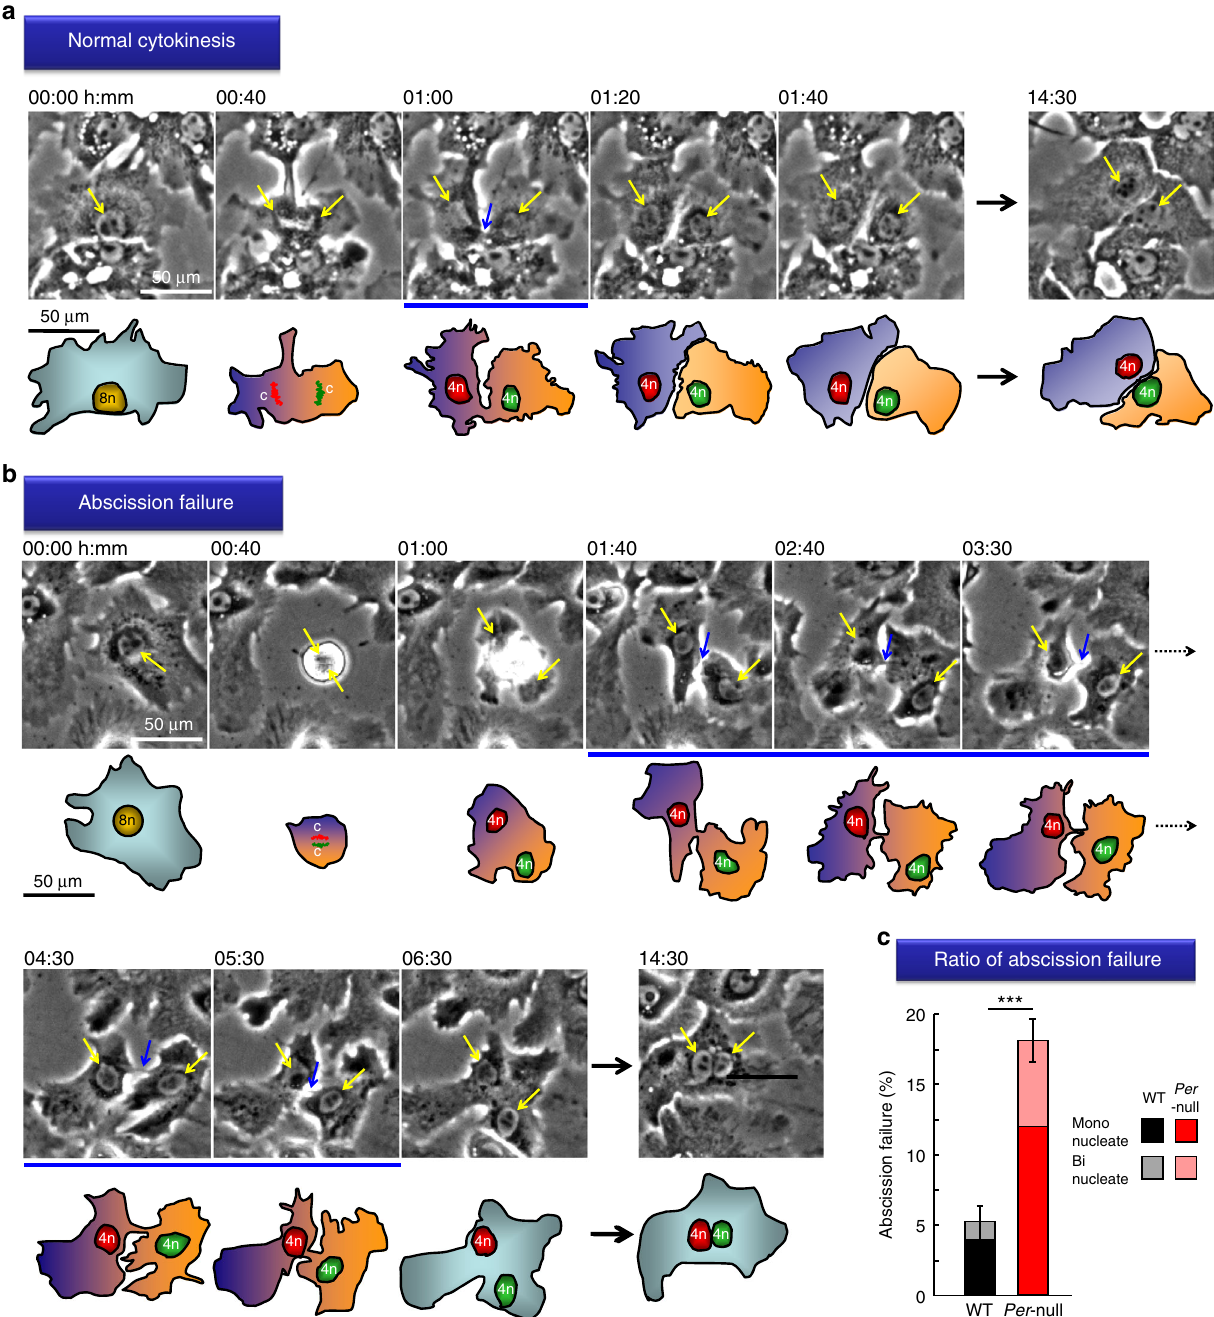
Fig. 3 Genetic ablation of Periods triggers abscission failure. Representative time-lapse images of cultured hepatocytes showing a normal cytokinesis and b abscission failure. Yellow arrows indicate the localization of nuclei and chromosomes of dividing hepatocytes. Blue arrows exhibit intercellular bridges between daughter cells. Cartoons corresponding to time-lapse images are shown with the number of chromosomes (c) in the gametes (n). Appearance of intercellular bridge (blue underlines) between daughter cells was normally transient (~20 − 40 min) for normal cytokinesis but was extremely long (1 – 4 h) for abscission failure cells. c Quanti fi cation of the percentage of abscission failure. A marked increase of the abscission failure ratio in Per -null hepatocytes compared to that in WT. Data are representative of at least three independent experiments. Values represent the mean ± SEM, *** P < 0.001 by Student ’ s unpaired t -test with Welch correction (WT, n = 526 cells; Per -null, n = 717 cells from fi ve experiments for each group). All scale bars, 50 μ